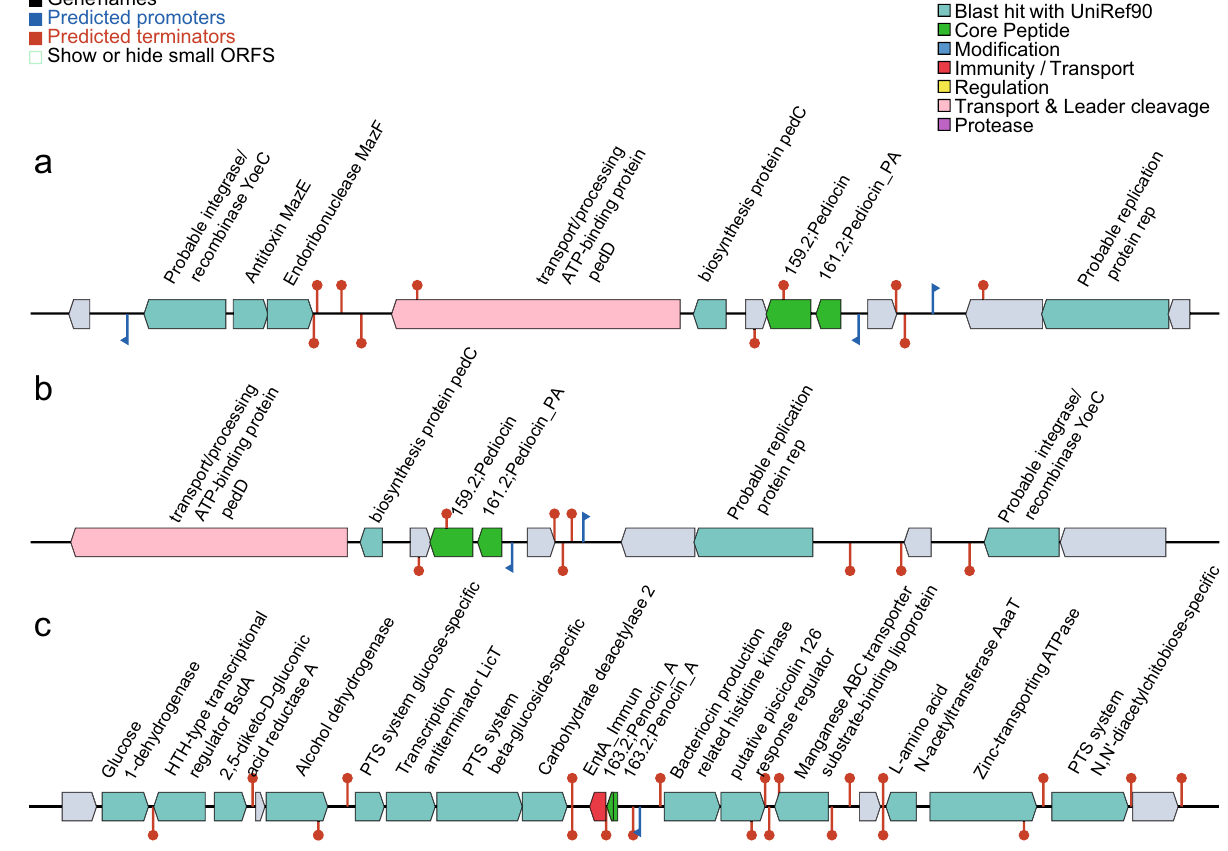
Figure 2. Putative bacteriocin gene clusters identified using BAGEL 4. ( a ) Putative bacteriocin found pST31BZ-2 from P. acidilactici ST31BZ; ( b ) Putative bacteriocin found pST75BZ and pST87BZ-1 from Pediococcus pentosaceus ST75BZ and ST87BZ; ( c ) Putative bacteriocin found in genome of Pediococcus pentosaceus ST75BZ and containing a pediocin PA-1 operon (Fig. 2b). Other pediocin-like bacteriocin operon found was annotated as penocin A (Fig. 2c), present in the strain’s genome. We also found point mutations in the 23S rRNA coding sequence predicted to confer resistance to macrolides (azithromycin) and streptogramins using ARIBA. Using KEGG GhostKoala pipeline, other resistance genes were also detected: Beta lactamase class A gene ( PenP ), a Cationic Antimicrobial Peptide (CAMP) resistance gene, the dltABCD operon (Dlt A/B/C/D), two Multidrug efflux pump genes ( EfrA/B and AbcA ); and a lincosamide resistance gene ( Lsa ). The genome of P. pentosaceus ST75BZ and ST87BZ presented similar values for size, GC content, number of predicted proteins and ribosomal operons as 65 strains of P. pentosaceus in China 11 . Strains P. pentosaceus ST75BZ and ST87BZ genome presented similar metabolic capabilities as P. acidilacti ST31BZ, however this strain has a reduced sugar transport capability, is able to synthesize lysine and is positive for genes encoding for a quorum sensing mechanism that we were not able to attribute to a distinct physiologic state or metabolic process (Supplementary Table 2). Pangenomic analysis of Pediococcus spp..